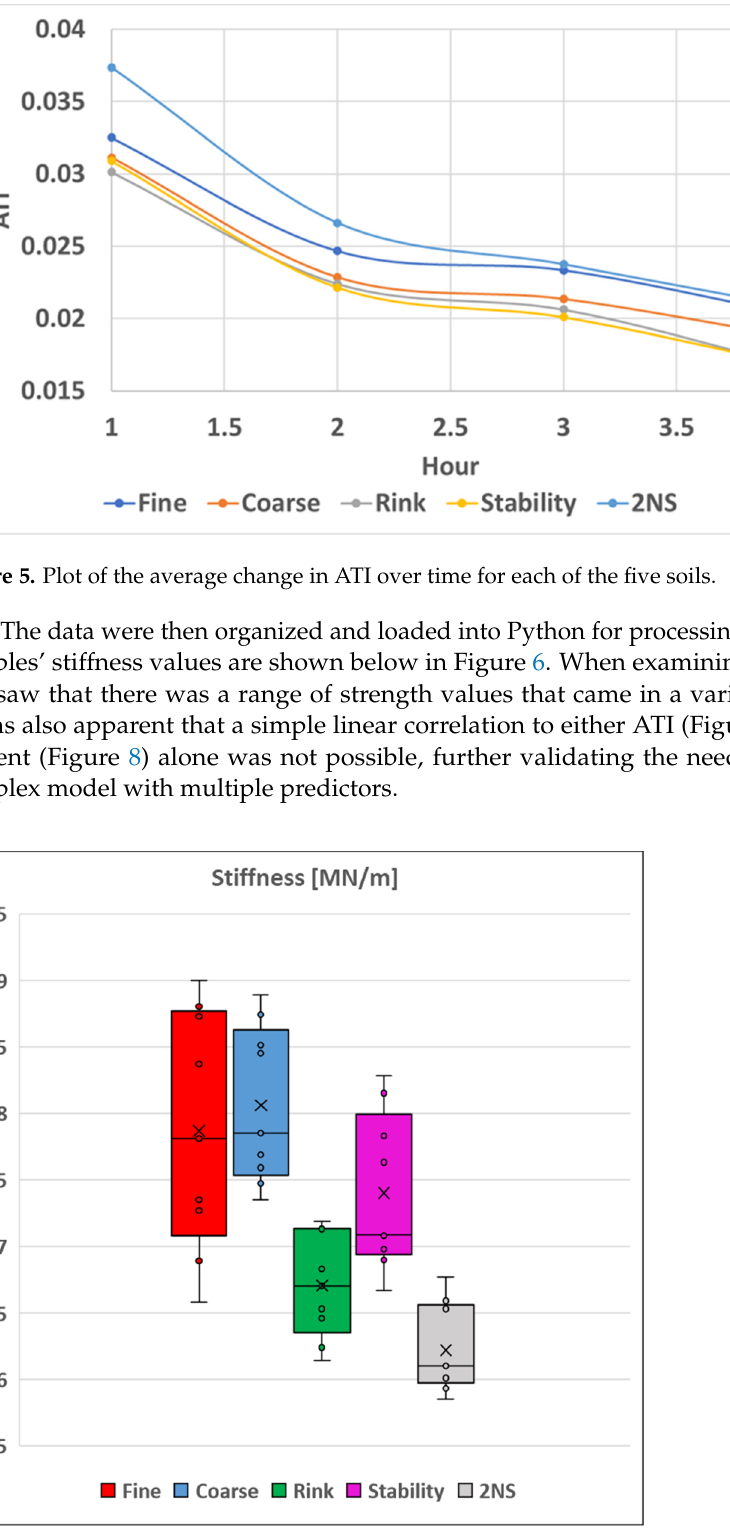
Figure 4. Plot of the average change in temperature over time for each of the five soils.